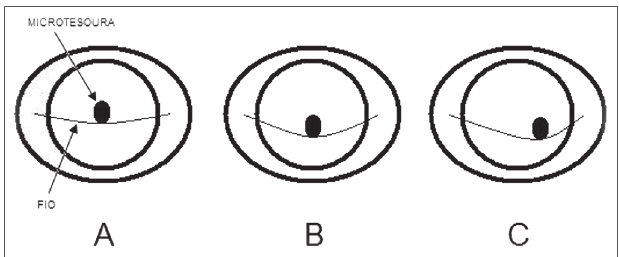
Figura 4. Desenho esquemático da vista interna do sistema de esta- bilização na 3ª (A), 5ª (B) e 6ª (C) etapas do teste. Note que, mesmo com o fio esticado (A e B), ocorre uma pequena deflexão para baixo, que auxilia na estabilização horizontal da